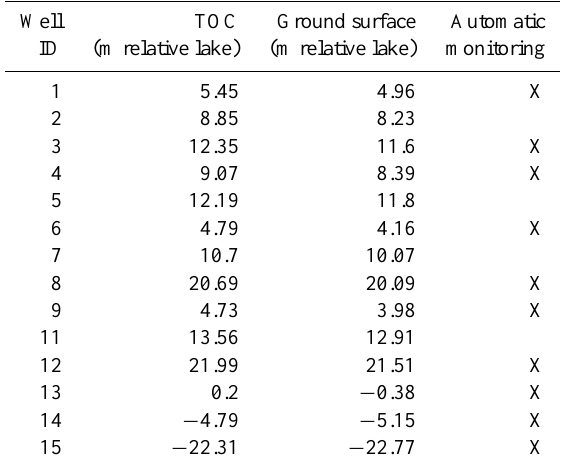
Table 2. Levels of top of casing (TOC) and ground surface (relative the lake level, 4 September 2010) for each groundwater well relative to the lake surface. Automatic monitoring in the well is marked by an